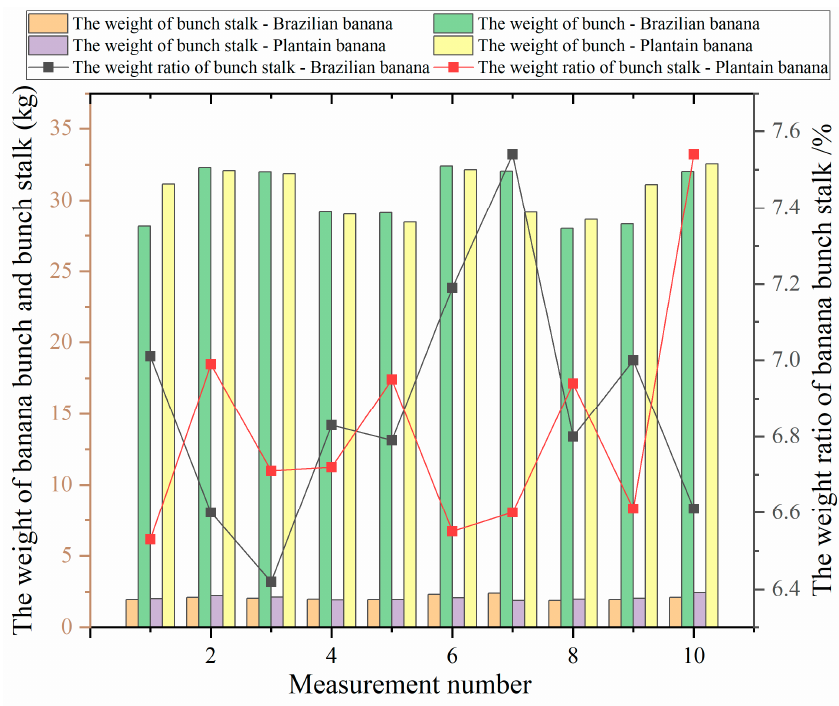
Figure 16. Measurement and statistical results of the weight of the banana bunch. According to the experimental results, the minimum, maximum and average values of the weight of bunch stalks we obtained were 1.906, 2.455, and 2.088 kg, respectively, with a standard deviation of 0.155 kg and a coefficient of variation of 7.443%. The minimum, maximum, and average values of the weight of bunches were 28.023, 32.562, and 30.492 kg, respectively; the standard deviation is 1.696 kg, and the coefficient of variation is 5.563%. The minimum, maximum, and average values of the weight ratio of bunch stalks were 6.422%, 7.544%, and 6.848%, respectively. The minimum, maximum, and average values of the weight of Brazilian banana bunch stalks were 1.906, 2.418, and 2.089 kg, respectively, with a standard deviation of 0.158 kg and a coefficient of variation of 7.563%. The minimum, maximum, and average values of the weight of Brazilian banana bunches were 28.023, 32.411, and 30.362 kg, respectively, with a standard deviation of 1.835 kg and a coefficient of variation of 6.044%. The minimum, maximum, and average values of the weight ratio of Brazilian banana bunch stalks were 6.422%, 7.544%, and 6.881%, respectively. The minimum, maximum, and average values of the weight of plantain banana bunch stalks were 1.923, 2.455, and 2.087 kg, respectively, with a standard deviation of 0.153 kg and a coefficient of variation of 7.321%. The minimum, maximum, and average values of the weight of plantain banana bunches were 28.453, 32.562, and 30.623 kg, respectively; the standard deviation was 1.534 kg, and the coefficient of variation was 5.009%. The minimum, maximum, and average values of the weight ratio of plantain banana bunch stalks were 6.528%, 7.539%, and 6.814%, respectively. By comparing the experimental results, we